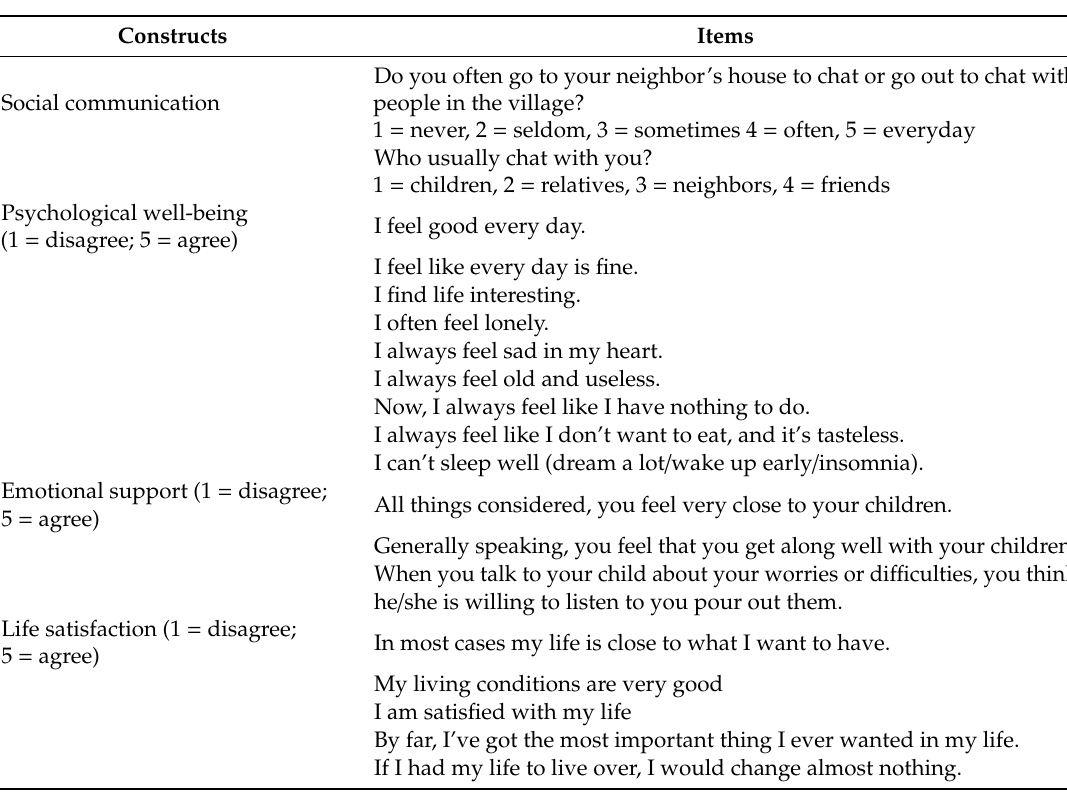
Table A1. A list of constructs and measured